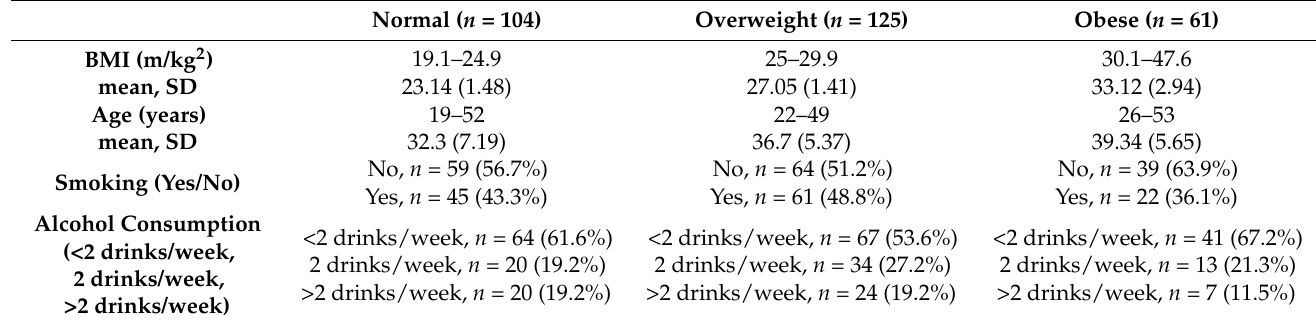
Table 1. Male subjects included in the study categorized according to their BMI